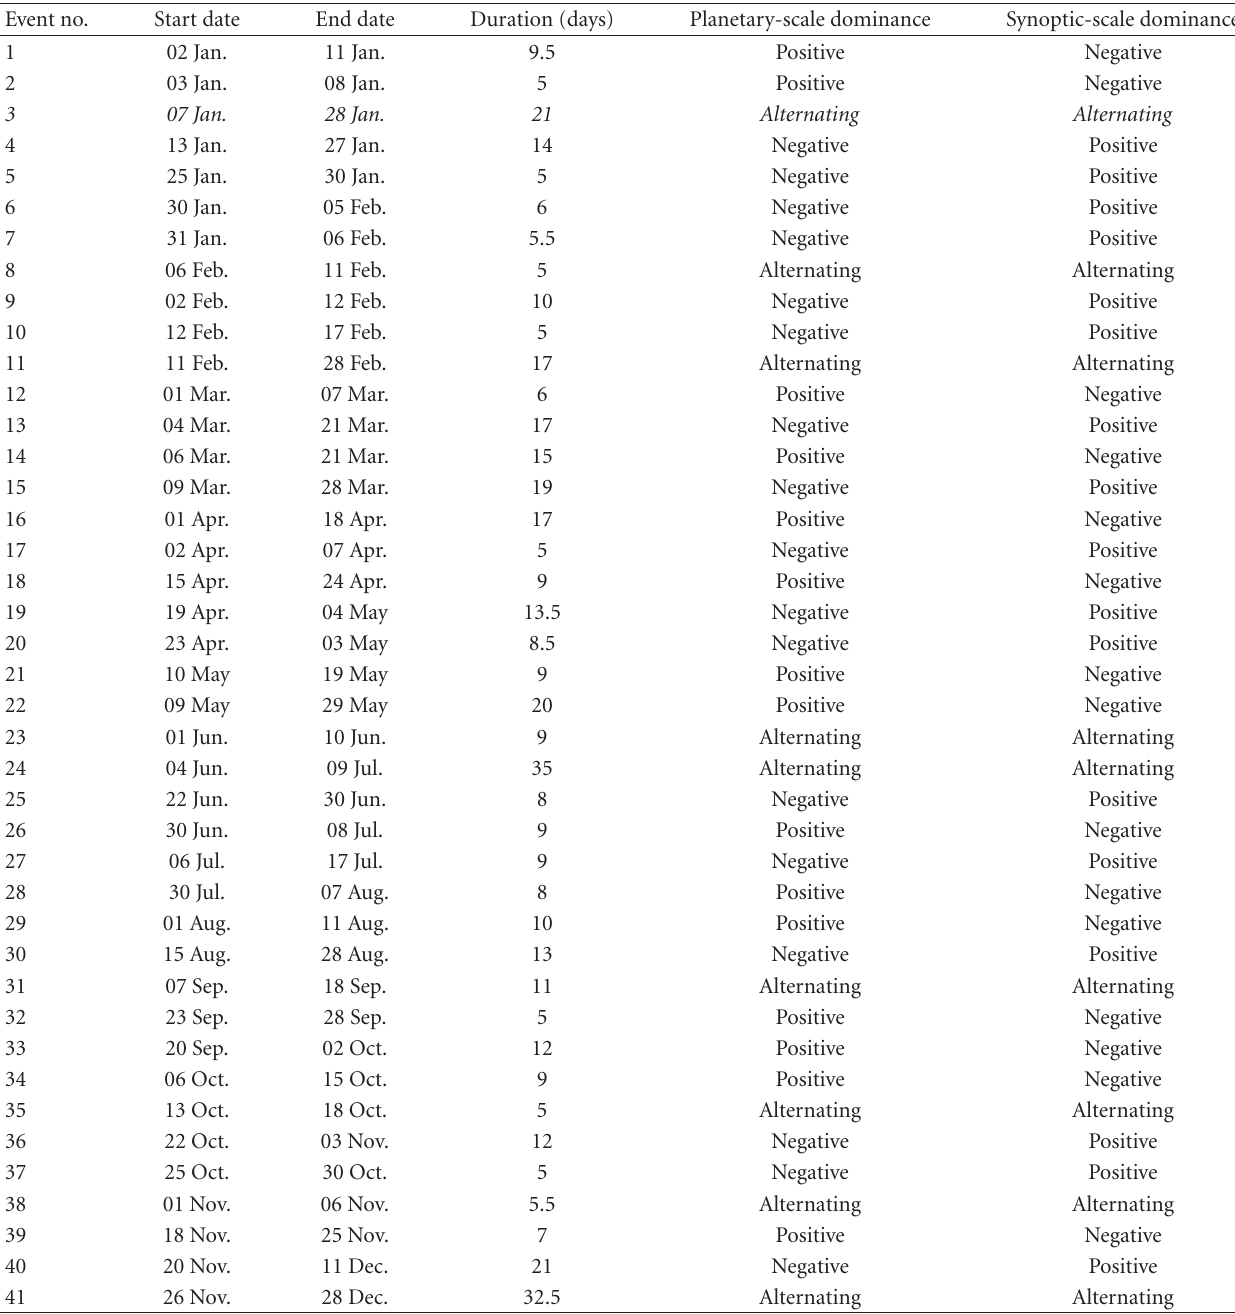
Table 4: Planetary-scale and synoptic-scale dominance results for all the blocking events during the year 2002. The italic entries are the selected case studies. See text for